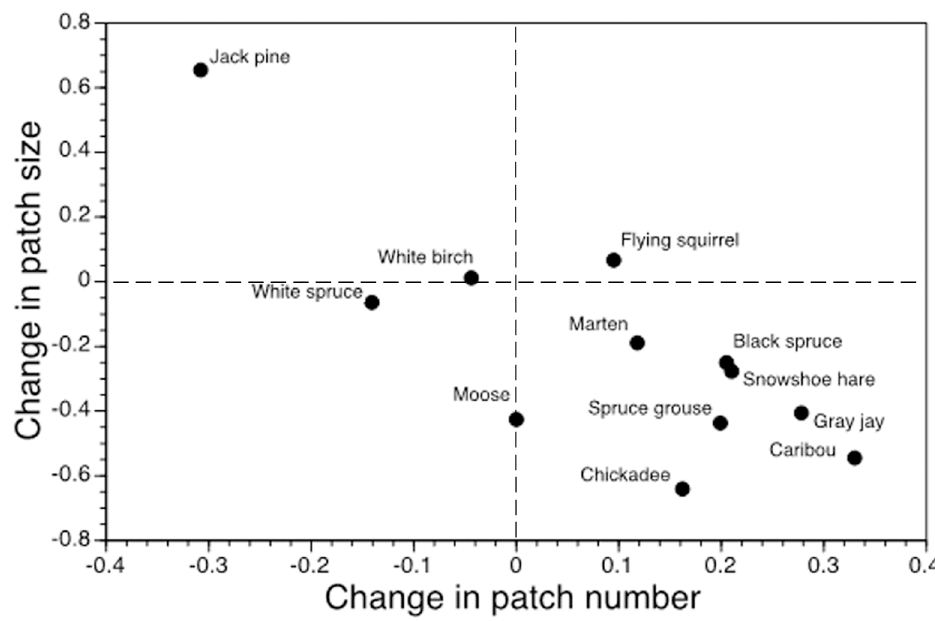
Fig 1. Dynamicsof climate-mediated fragmentation of suitable patches for 12 boreal-obligate species. The units are proportional change in range-widepatch number relativeto proportional change in patch size (2080). Zero change reflects stationary dynamics, positive values reflect increase, and negative values represent